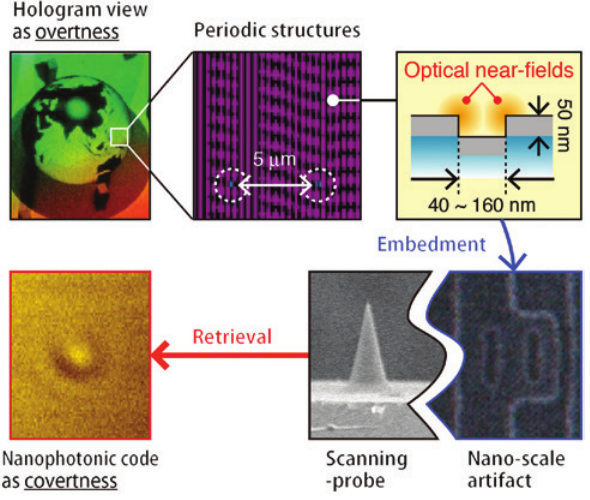
Figure 3: Schematic diagram for the concept of a nano-/macro- hierarchical hologram with a nanophotonic code embedded within the embossed structure of the hologram.